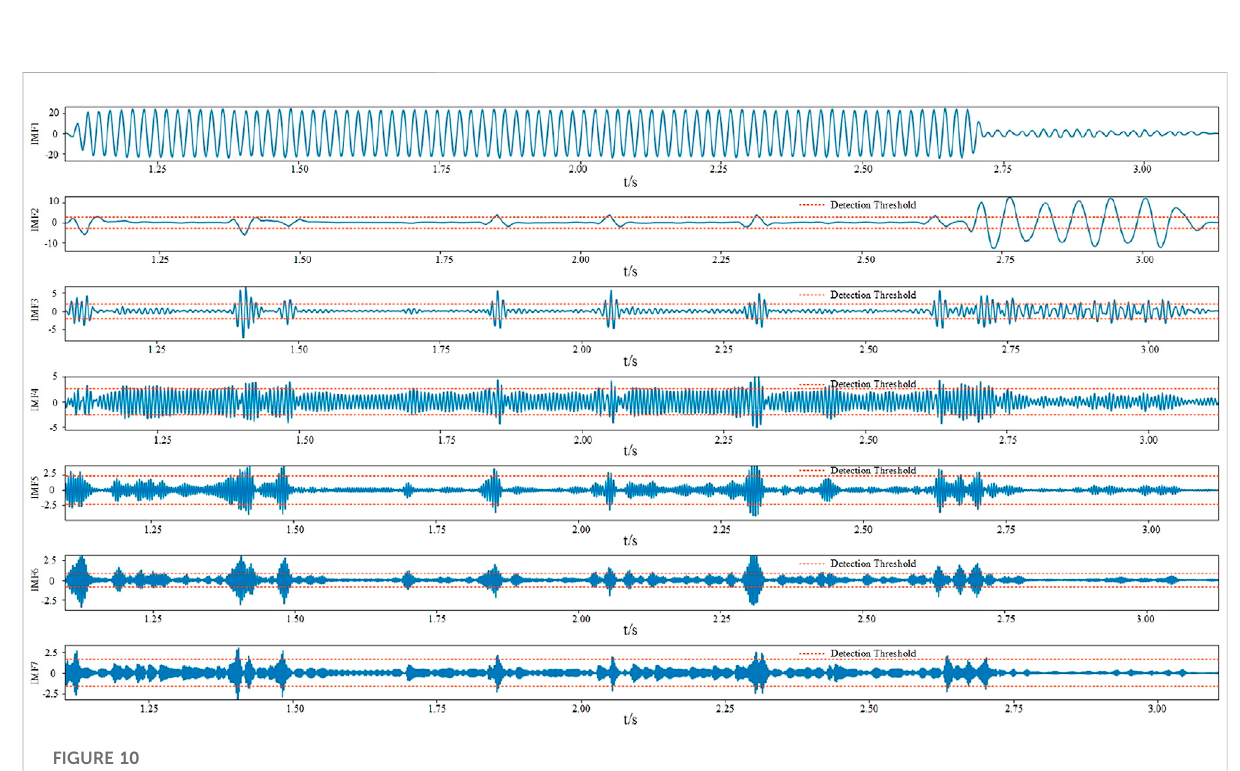
FIGURE 10 Variational modal decomposition of components at each